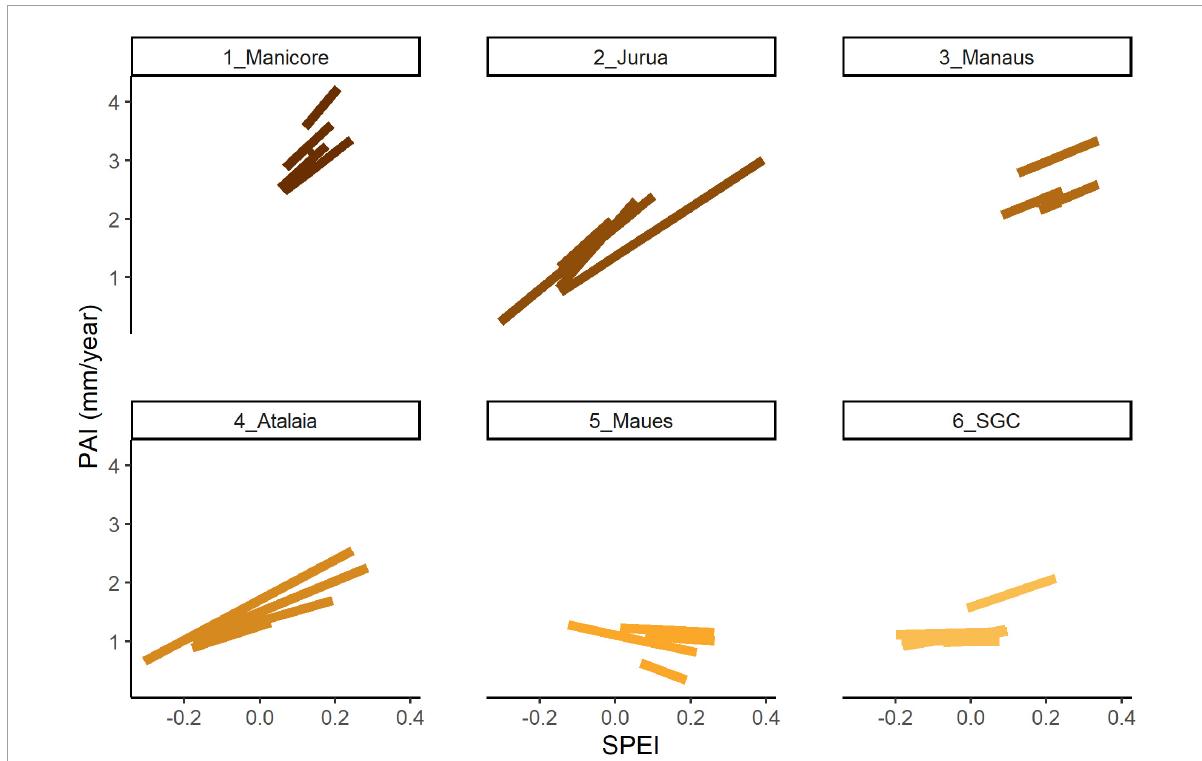
FIGURE5 The linear mixed-model predictions show the periodic annual increment (PAI) of Eschweilera coriacea in mm/year responding the interaction between soil fertility and drought index. Sites are distributed in descending order according to the soil fertility gradient. SPEI corresponds to the Standardized Precipitation-Evapotranspiration index (drought index). The trend lines are the values predicted by the linear mixed model for each tree. Acronyms of the study sites: 1_Manicore: Manicoré; 2_Jurua: Juruá; 3_Manaus: Manaus; 4_Atalaia: Atalaia do Norte; 5_Maues: Maués; 6_SGC: São Gabriel da